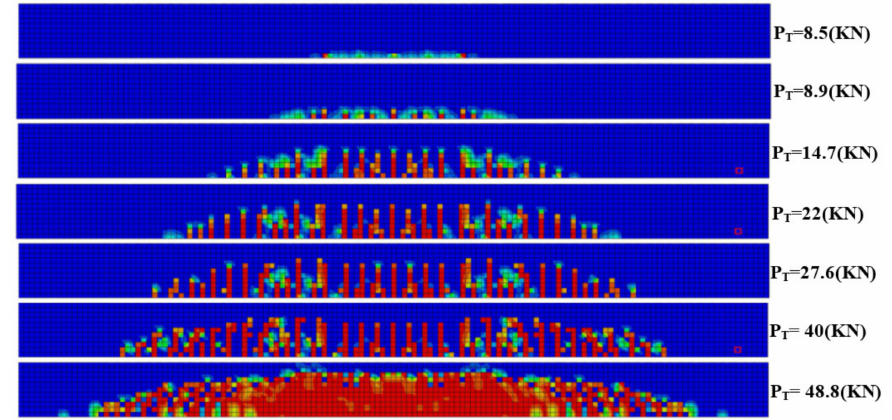
Figure 4. Crack formation at various load levels in ABAQUS (P T = 2